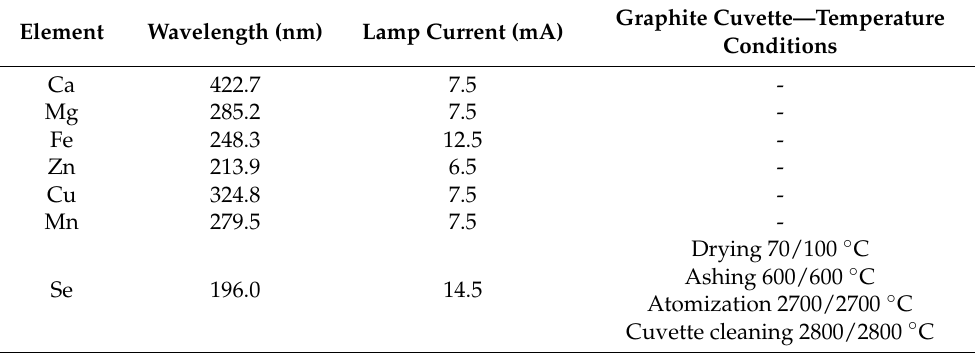
Graphite Cuvette—Temperature Conditions